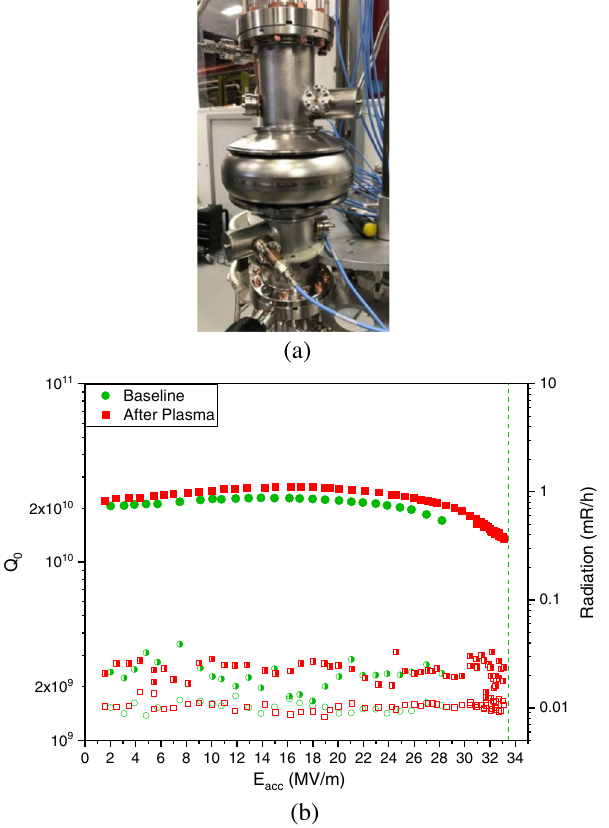
FIG. 5. Part (a) shows a single-cell cavity with HOM couplers. Part (b) shows the results of the rf tests measured at 2 K before (green) and after (red) plasma processing. The baseline rf test has been intentionally limited at 28 MV = m at 2 K to avoid quench- ¼ 33 . 5 MV = m during ing. The quench field was reached at E acc the 1.4 K baseline test and the vertical dotted line indicates the quench field value. As explained in Sec. III, solid symbols are used to plot the Q 0 vs E curve, empty symbols for the radiation acc detected from the top detector, and half-filled symbols for the bottom radiation